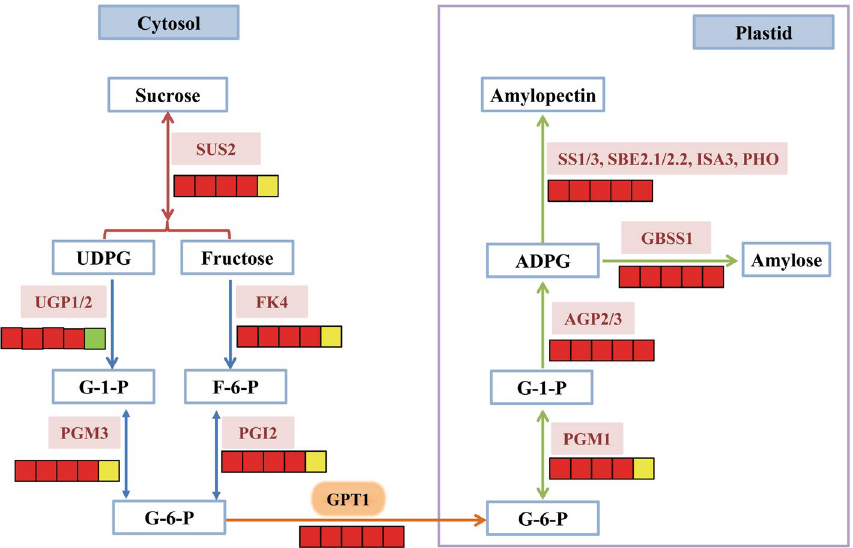
Figure 7. Temporal expression patterns of enzymes involved in starch biosynthesis in developing CCSK. The icons below each enzyme show the result of DESeq analysis, from left to right: 60:50 DAF, 70:60 DAF, 80:70 DAF, 90:80 DAF and 100:90 DAF; red, up-regulation; yellow, no significant difference; green,